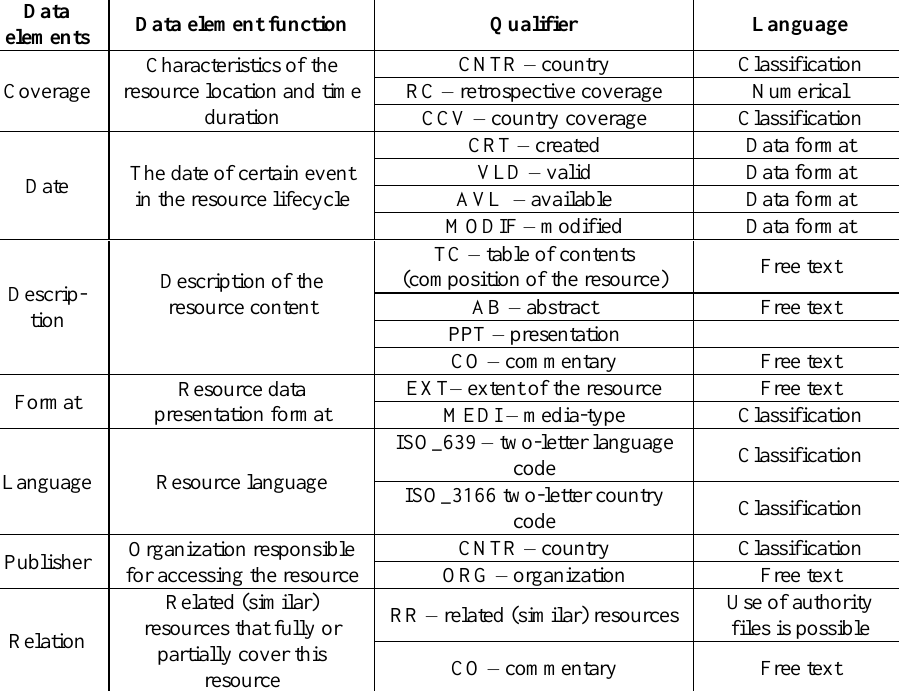
Table 2. Metadatabase